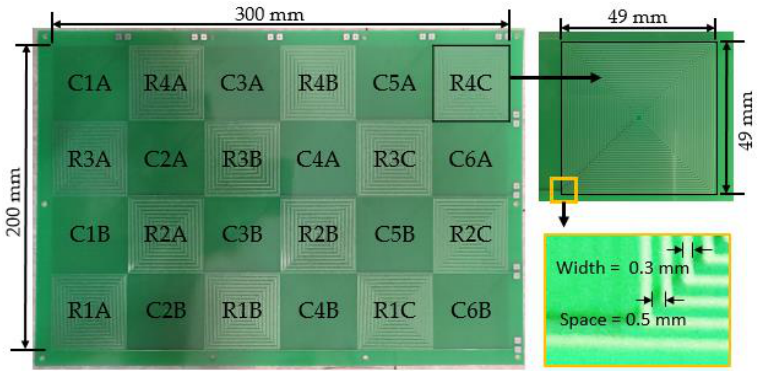
Figure 5. The detection coil set array.